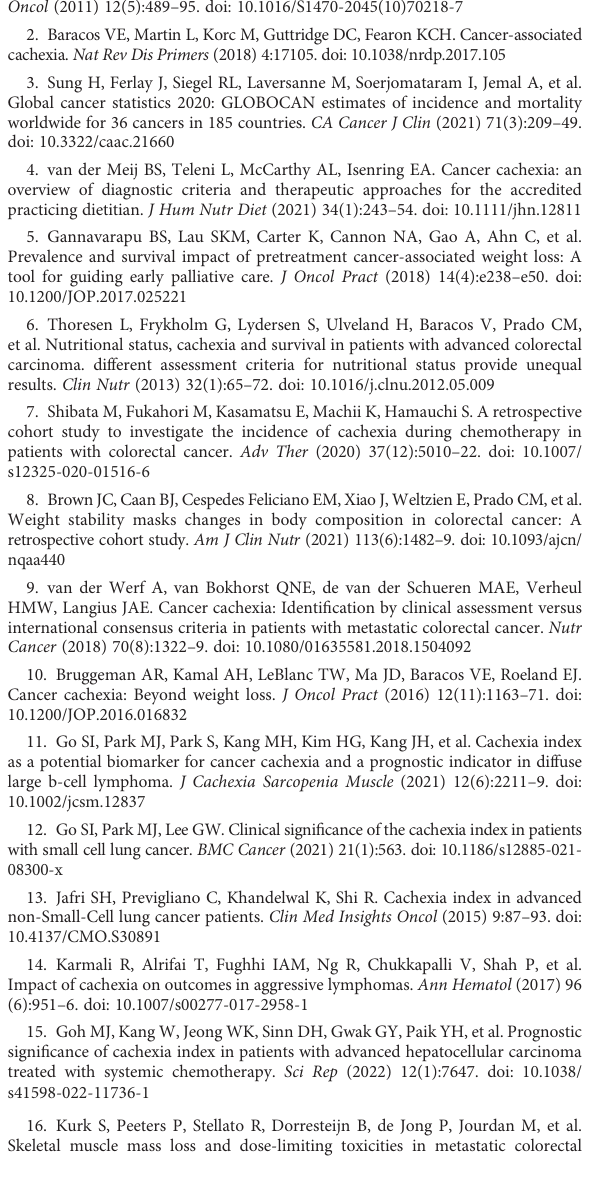
SUPPLEMENTARY FIGURE 1 Receiver operating characteristic (ROC) curve of cachexia index (CXI) and major complications for determining the cut-off values of low and high CXI groups (A) male patients; (B) female